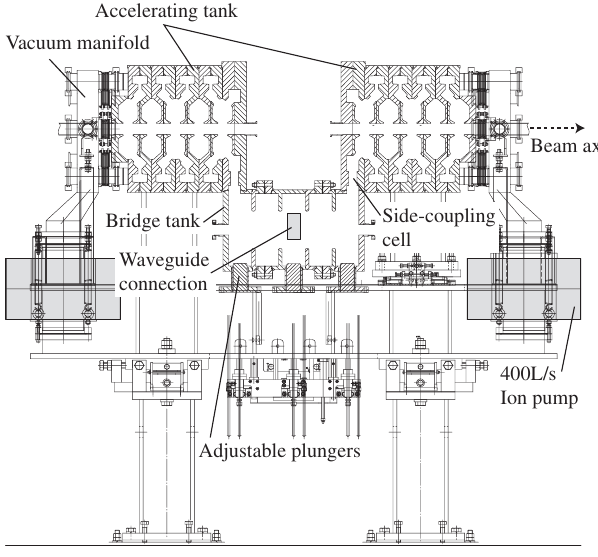
FIG. 3. Half-cell piece of the ACS as viewed from the accelerating-cell side (see Fig. 4). FIG. 4. Configuration of the ACS buncher